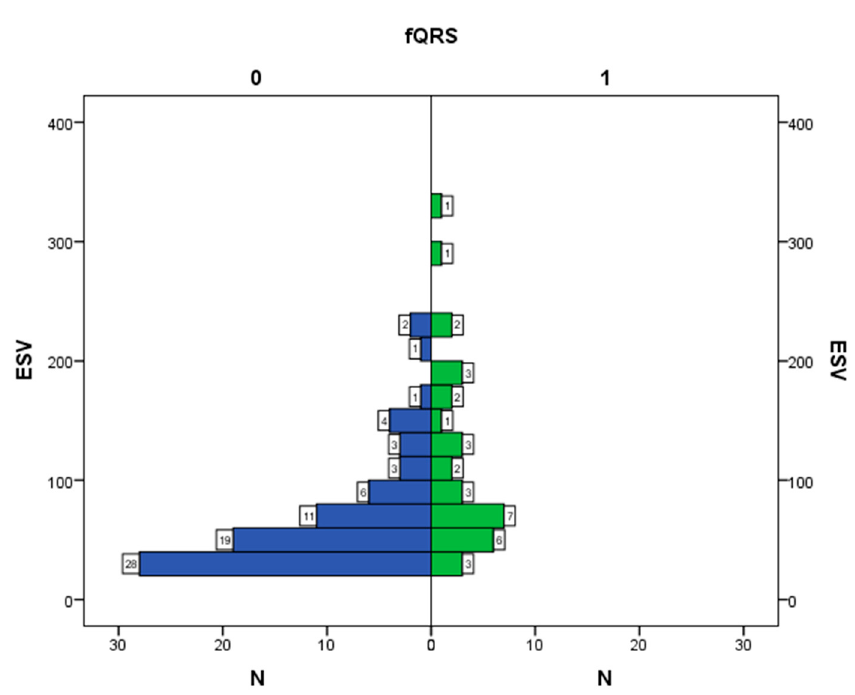
Figure 5. Interrelation between fQRS and end-systolic volume; N—number of observations, fQRS— fragmented QRS complex, ESV—end-systolic volume, 0—there is no fragmented QRS complex, 1— there is fragmented QRS complex.